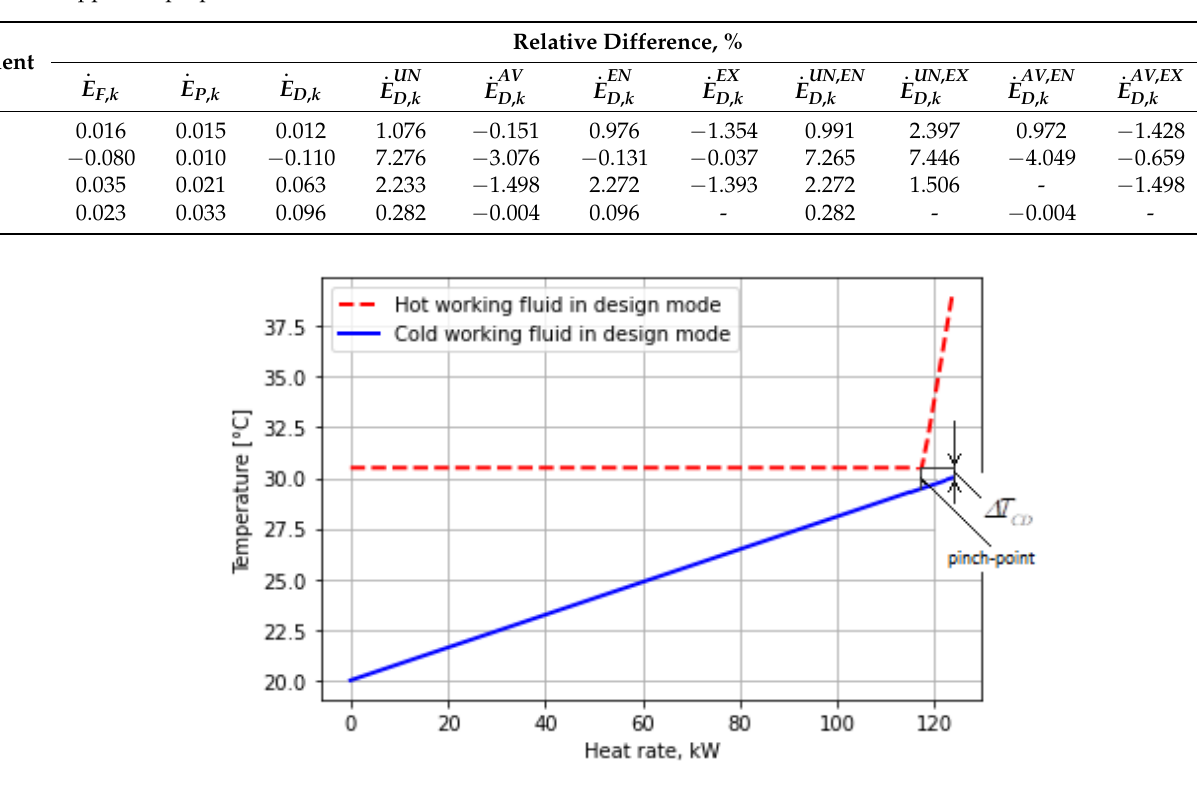
Figure 2. Q-T diagram of the condenser for the cycle with unavoidable parts of the exergy destruction. Table 8. Comparison of the results obtained from the conventional advanced exergy analysis and those obtained on the basis of the approach proposed in this work.